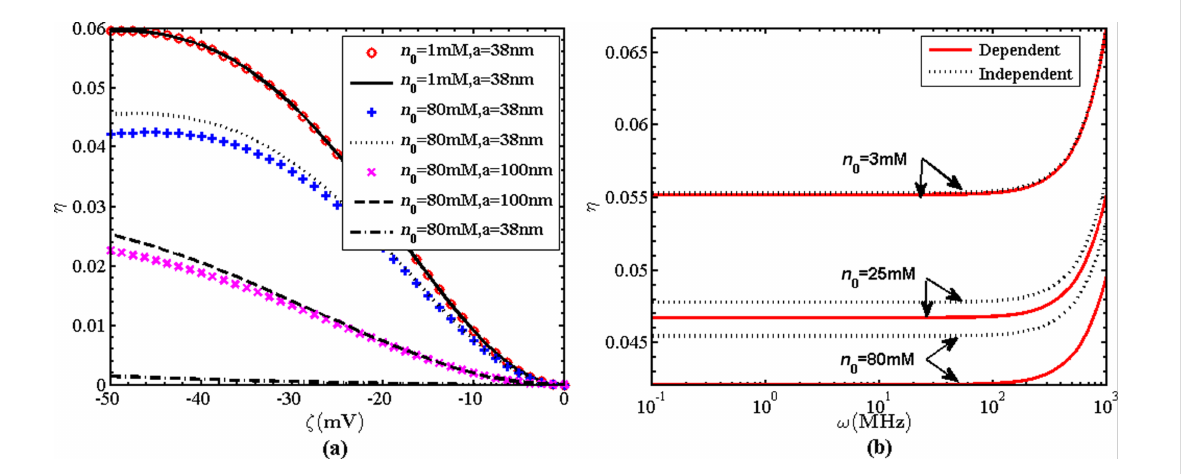
Figure 4: (a) Variation of η as function of ζ at different values of a and n 0 ( ω = 10 − 1 MHz, b 0 = 20 nm) under the condition of surface charge-depend- ent slip (circles, plus signs and diagonal crosses), surface charge-independent slip (solid, dashed and dotted lines) and no-slip (dashdot line); (b) variation of η as function of ω for the charge-dependent and charge-independent cases ( a = 38 nm, b 0 = 20